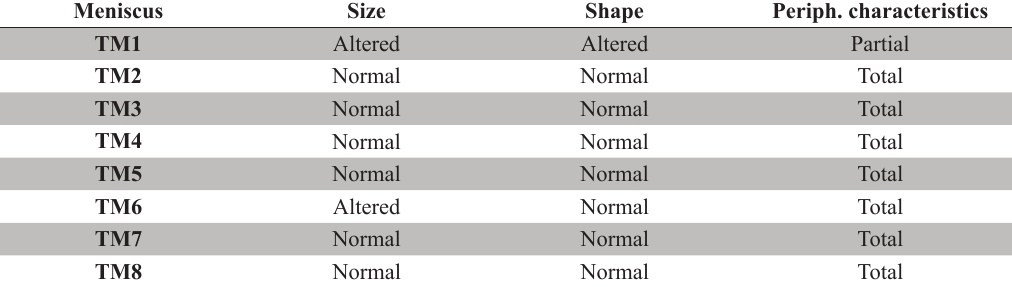
Size, shape and peripheral characteristics of treated